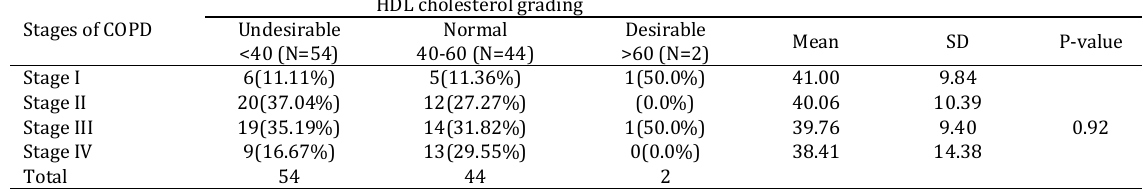
COPD: chronic obstructive pulmonary disease Table 3. High-density lipoproteins cholesterol in relation to chronic obstructive pulmonary disease stages Stages of COPD